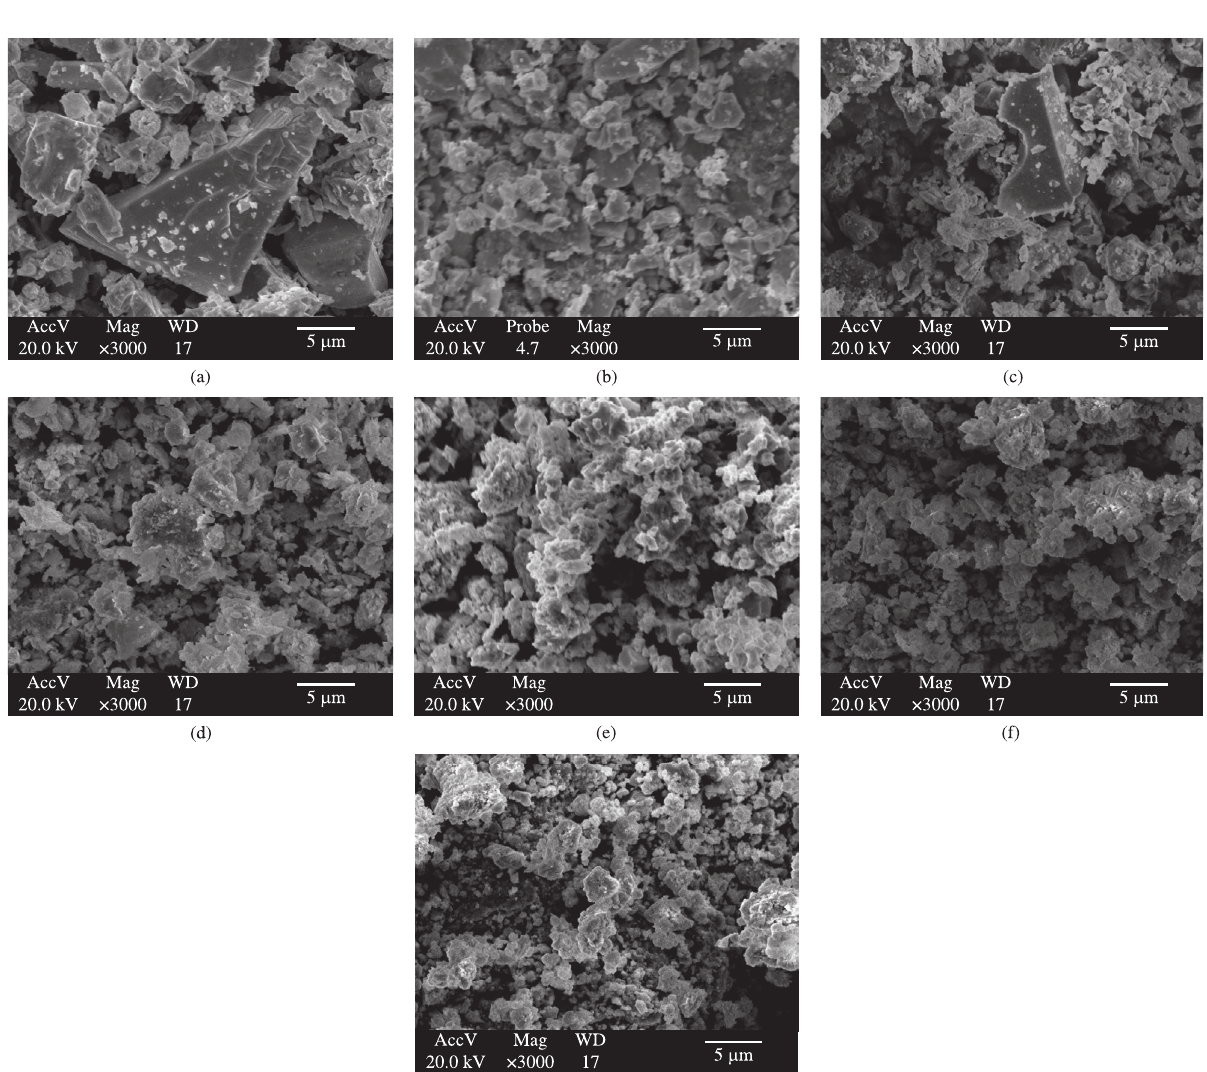
Figure 2. SEM micrographs of the WC-20Ni powders after ball milling for: a) 1 hour; b) 2 hours; c) 4 hours; d) 8 hours; e) 16 hours; f) 32 hours; and g) 64